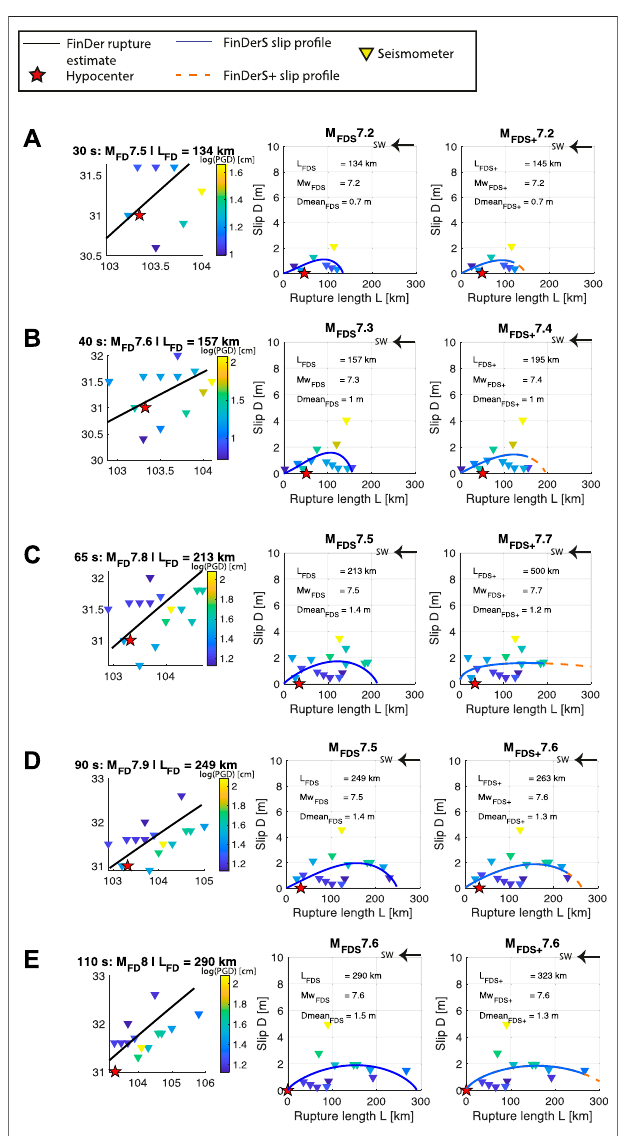
FIGURE 7 | Playback results for the M W 7.9 Wenchuan earthquake (L ∼ 300 km, ∼ 100 sruptureduration)ata)30 s,b)40 s,c)65 s,d)90 sand e) 110 s from event origin. Follows Figure 5 . See Table 2 for